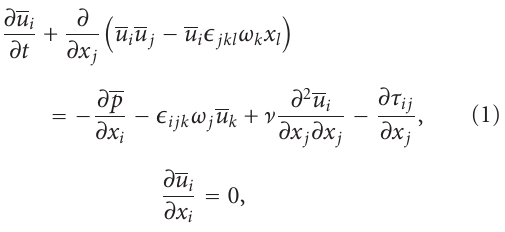
dominated by the interaction of the free stream flow with the strong reverse flow from reverse propulsor rotation as shown in Figure 1(b). This interaction forms a highly unsteady vortex ring around the propulsor. Crashback displays unsteady massively separated flow over the propulsor blades. LES is therefore a suitable simulation methodology for